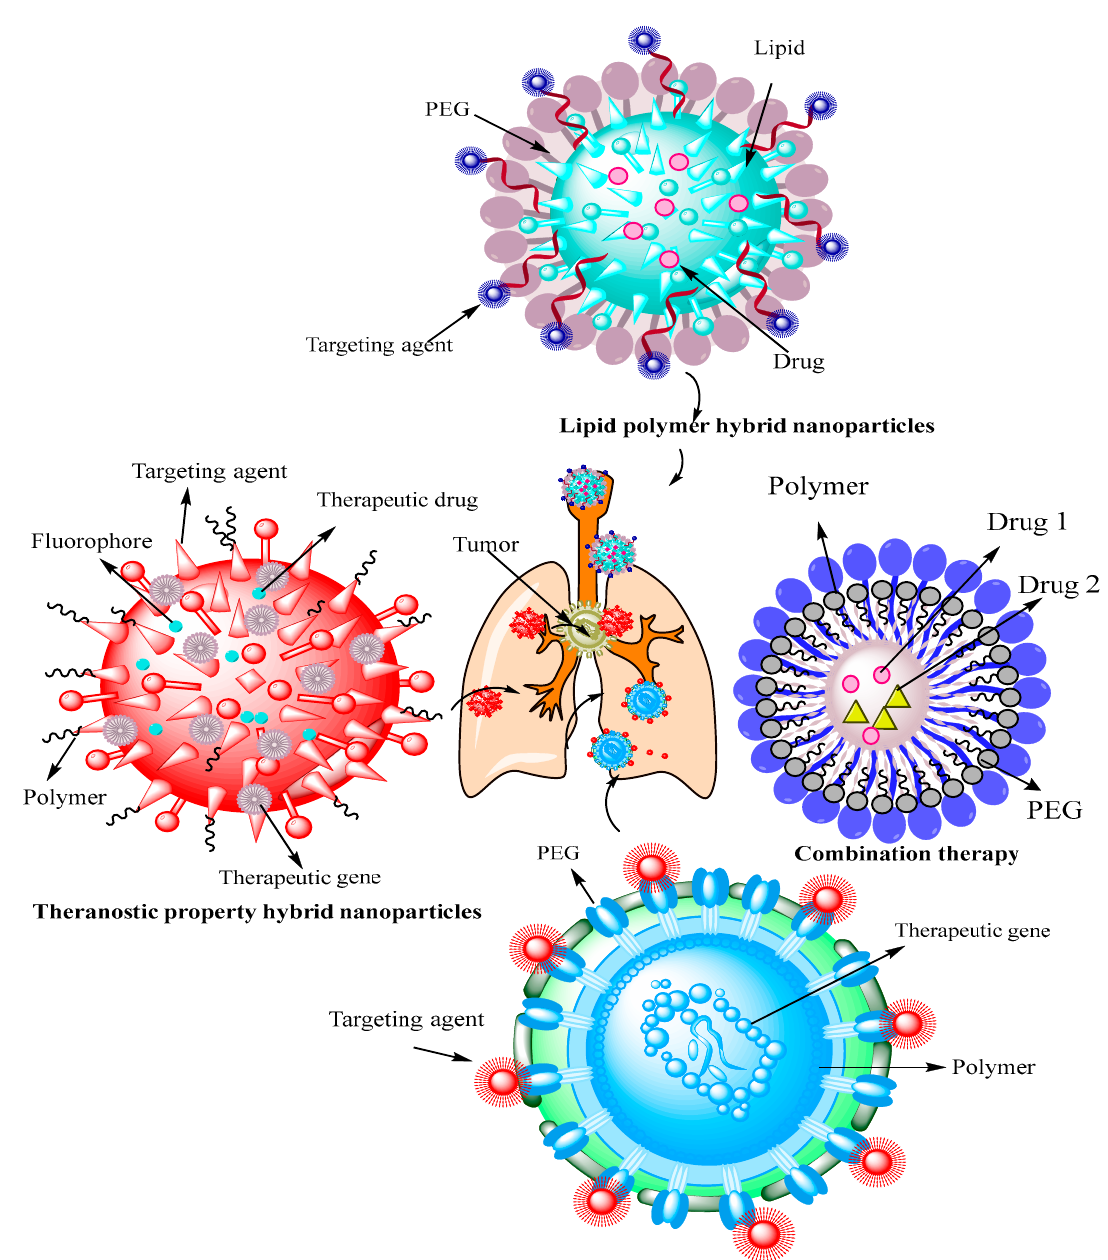
Figure 4. Schematic representations of different types of hybrid nanoparticles used for lung cancer targeting (i.e., theranostic hybrid nanoparticles, gene hybrid nanoparticles, combination therapy of hybrid nanoparticles and lipid polymer hybrid